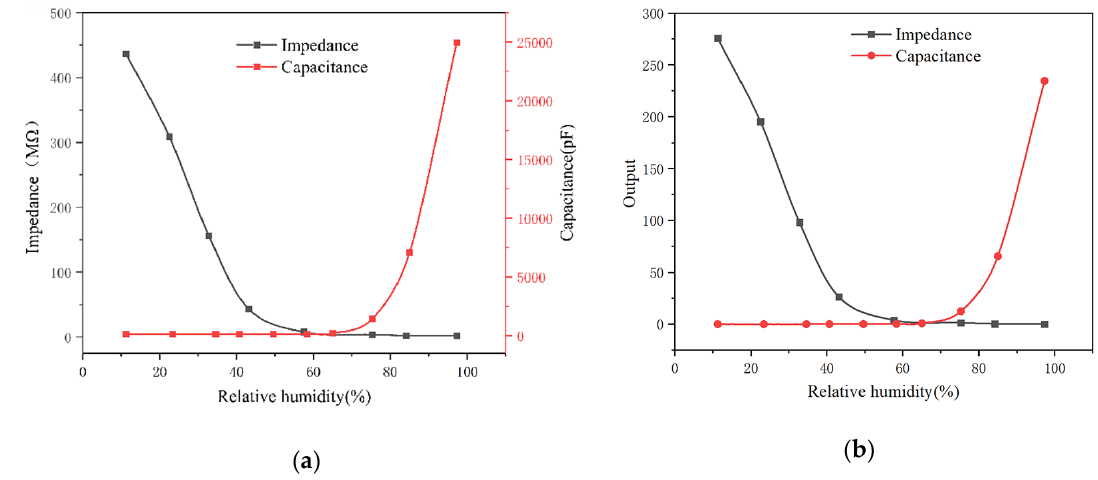
Figure 6. Micro-arc MgO humidity sensor ( a ) impedance and capacitance versus relative humidity; ( b ) output versus relative humidity.